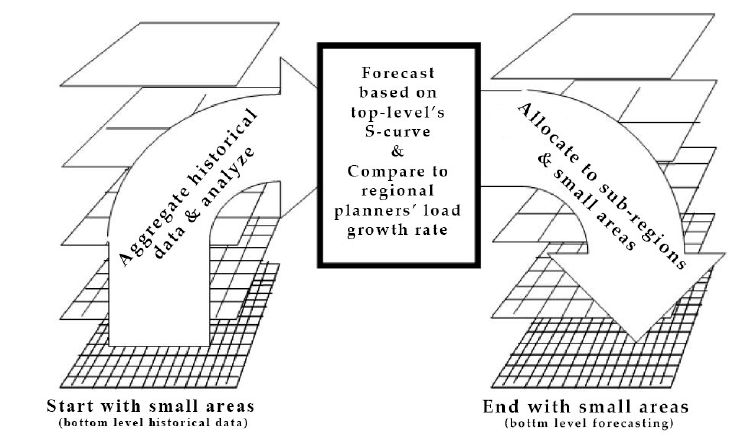
Figure 3. Forecasting module: Bottom-up aggregation and top-down allocation [29].